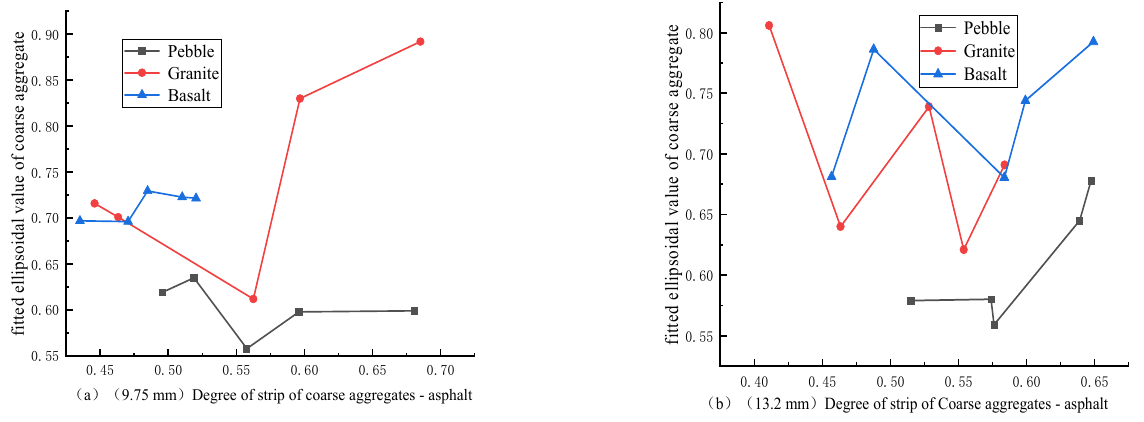
Figure 23. Relationship between degree of strip and fi tt ed ellipsoidal value.